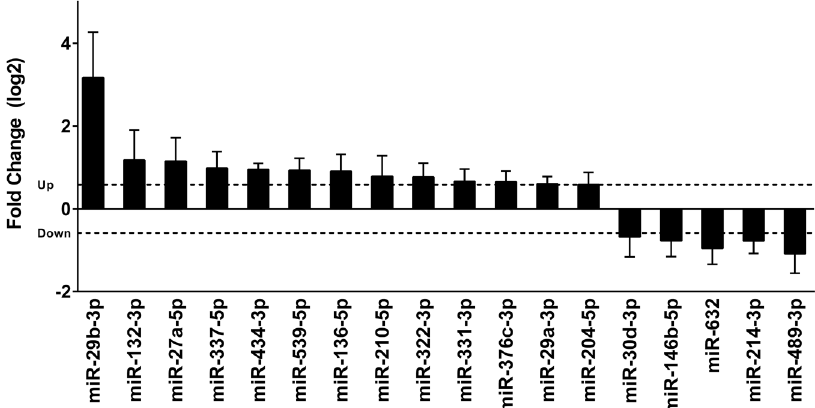
Figure 3. Identification of differentially expressed miRNAs in soleus muscle of cardiac cachexia group (CC) compared to their level of expression in control group (CT; set at a value of 0), as detected by low-density miRNA arrays. Y-axis represents log2-fold change. The dashed line indicates fold change value of 1.5. The expression of each miRNA was normalized by the expression of the small RNAs snoRNA135, Y1, U87, and MammU6. Data are expressed as mean ± SD; n = 6 per group. * p < 0.05: statistical significance versus CT